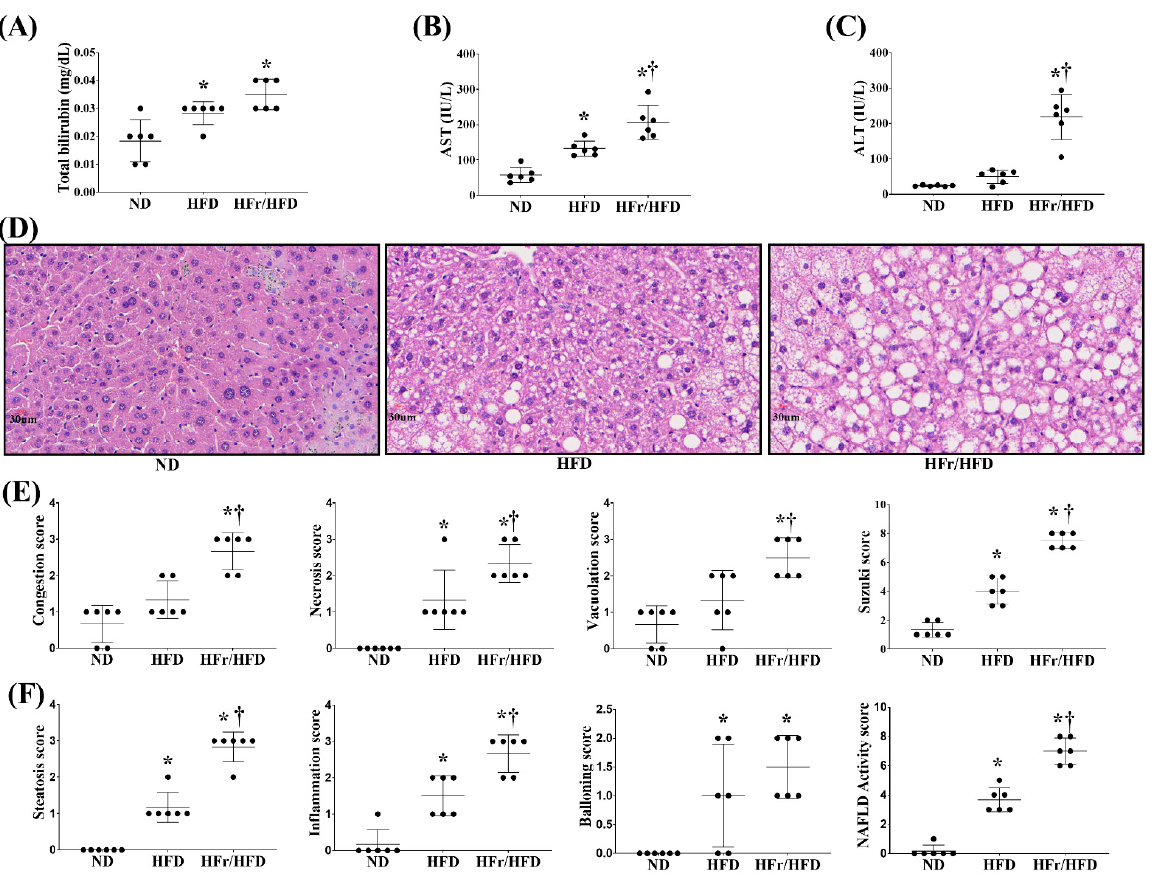
Figure 3. Plasma concentrations of ( A ) alanine aminotransferase (ALT), ( B ) alanine aspartate (AST), and ( C ) total bilirubin. ( D ) Representative microscopic findings of liver stained with hematoxylin– eosin (×200) and ( E ) parameters of Suzuki score (congestion, necrosis and vacuolation). ( F ) Parameters of NAFLD activity score (steatosis, inflammation, and ballooning degeneration). Data were obtained from 6 mice in each group and presented as mean ± standard deviation. ND: normal diet group. HFD: high-fat diet group. HFr/HFD: high-fat diet plus 30% fructose in drinking water group. NAFLD: non-alcoholic fatty liver disease. * p < 0.05, versus the ND group; † p < 0.05, the HFr/HFD group versus the HFD group.